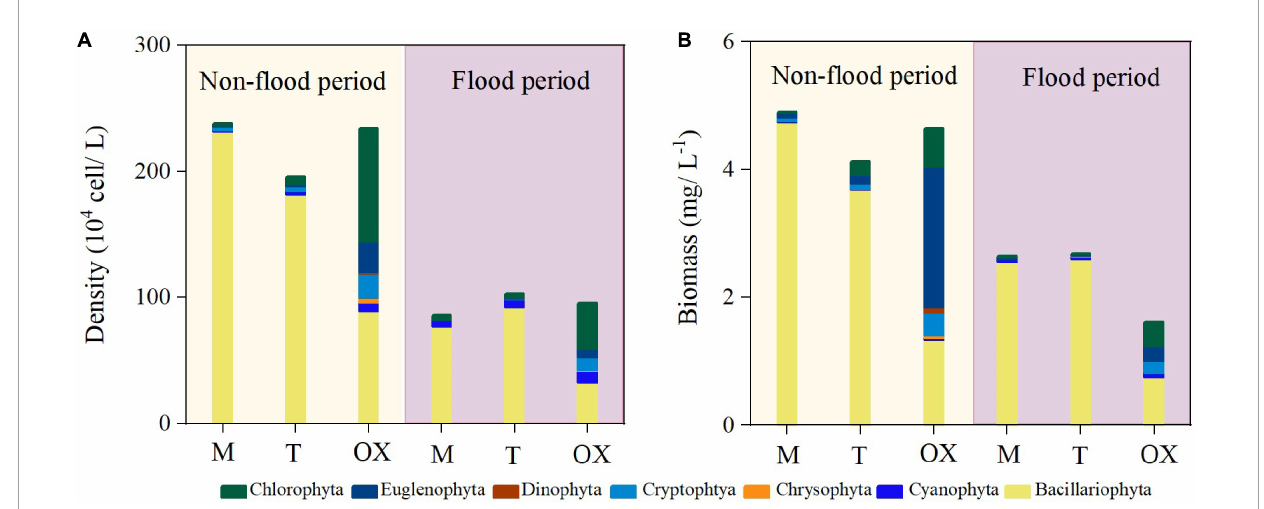
FIGURE2 Phytoplankton mean (A) density and (B) biomass in the mainstream (M), tributaries (T), and oxbow lakes (OX) during two contrasting hydrological periods of the White River Basin.